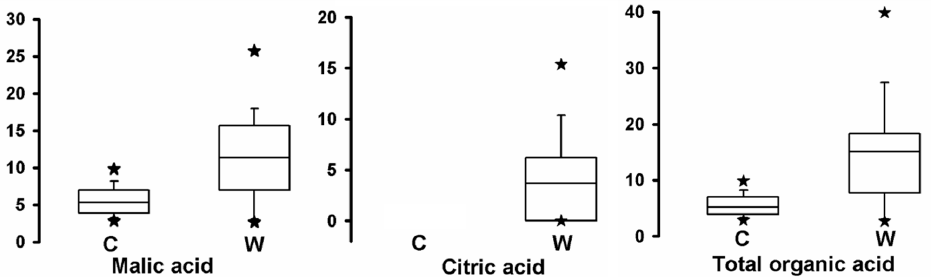
Figure 4. Ranges and distributions of organic acid contents (mg/g fresh weight (FW)) in cultivated and wild apple fruits. The mean values are indicated by horizontal lines in the interior of the box. The distribution for 50% of the data are indicated by the box. Approximately 95% of the data exist within the whiskers. The data that fall outside these whiskers are indicated by solid stars. W, wild fruits; C, cultivated fruits.